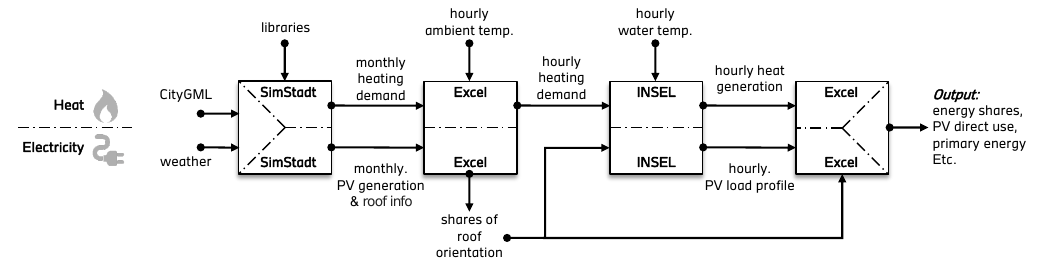
Figure 4. Simulation and calculation sequence (the upper part shows the sequence for calculating the heat demand, the lower part shows the electricity side including the PV